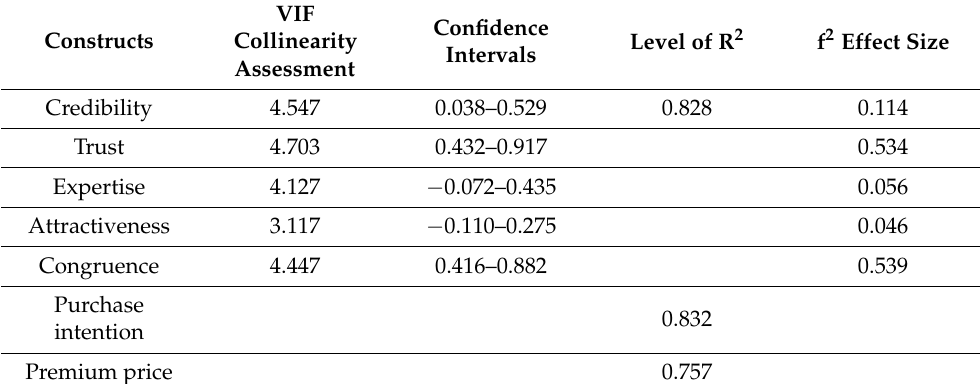
Table 5. Structural model